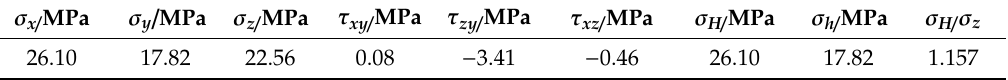
Table 4. In situ stress under geodetic coordinates of test points in the PDS No. 1 coal mine.